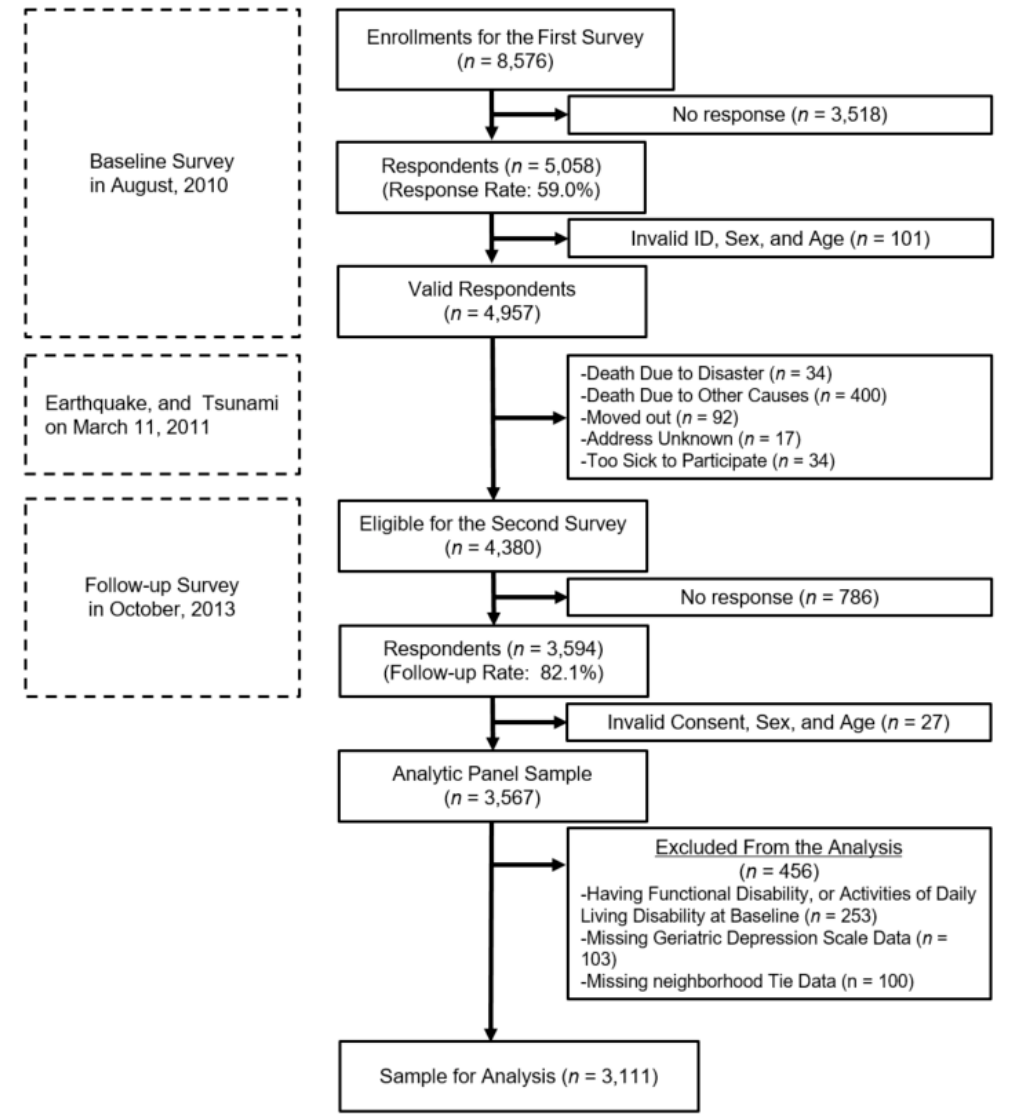
Figure 1. Participant flow of the present study.